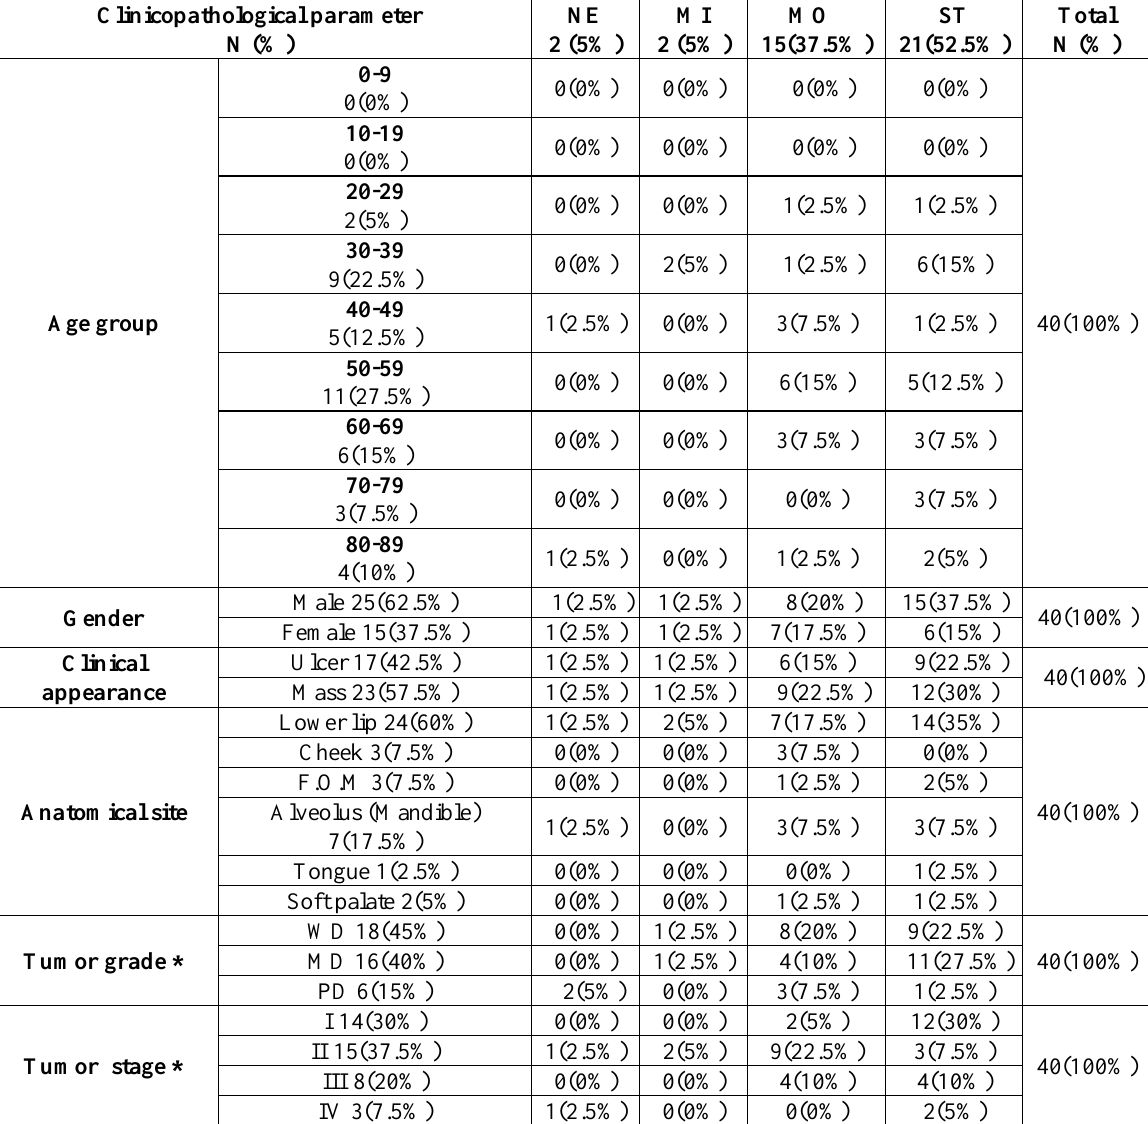
Table 1: Clinicopathological finding vs. Immunohistochemical expression of AKT